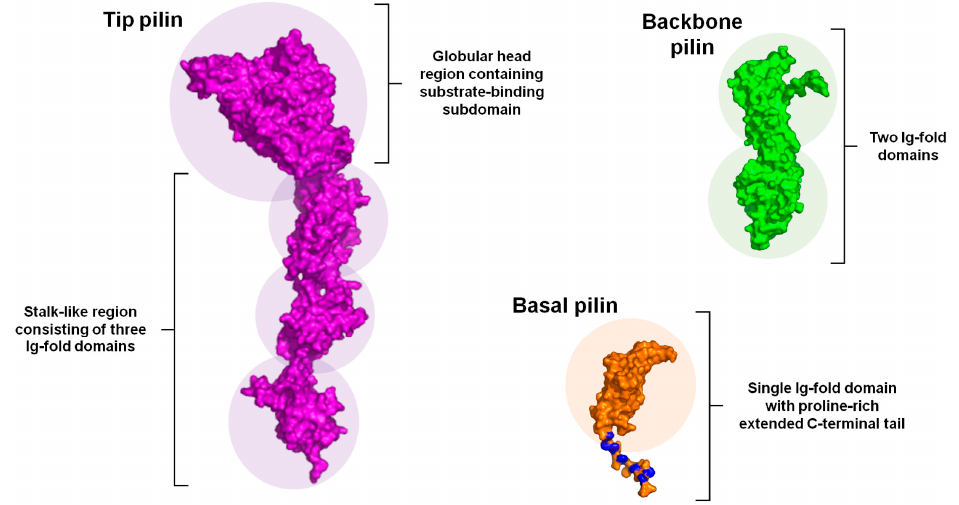
Figure 2. Three-dimensional view of the tip, backbone, and basal pilin structures within a typical sortase-dependent pilus. Shown are representative tertiary structures of the three types of pilin subunits. The structure of the tip pilin is comprised of a stalk-like region consisting of three Ig-fold domains (e.g., CnaA or CnaB), upon which rests a globular head region that contains the substrate-binding domain. The C-terminal LPXTG peptide is normally situated within the bottom subdomain. The backbone pilin structure is shown having two Ig-fold domains, with the linking lysine and the LPXTG peptide located within the upper and lower domains, respectively. The basal pilin structure is depicted with a single Ig-fold domain that includes a proline-rich (blue) extended C-terminal tail. All domain regions are highlighted by circular background shading. Structural visualization of the tip, backbone, and basal pilins was rendered by PyMol (http://www.pymol.org/) using protein atomic coordinates (2WW8, 3B2M, and 3LKQ, respectively) retrieved from the RCSB Protein Data Bank (http://www.rcsb.org/pdb/home/home.do).